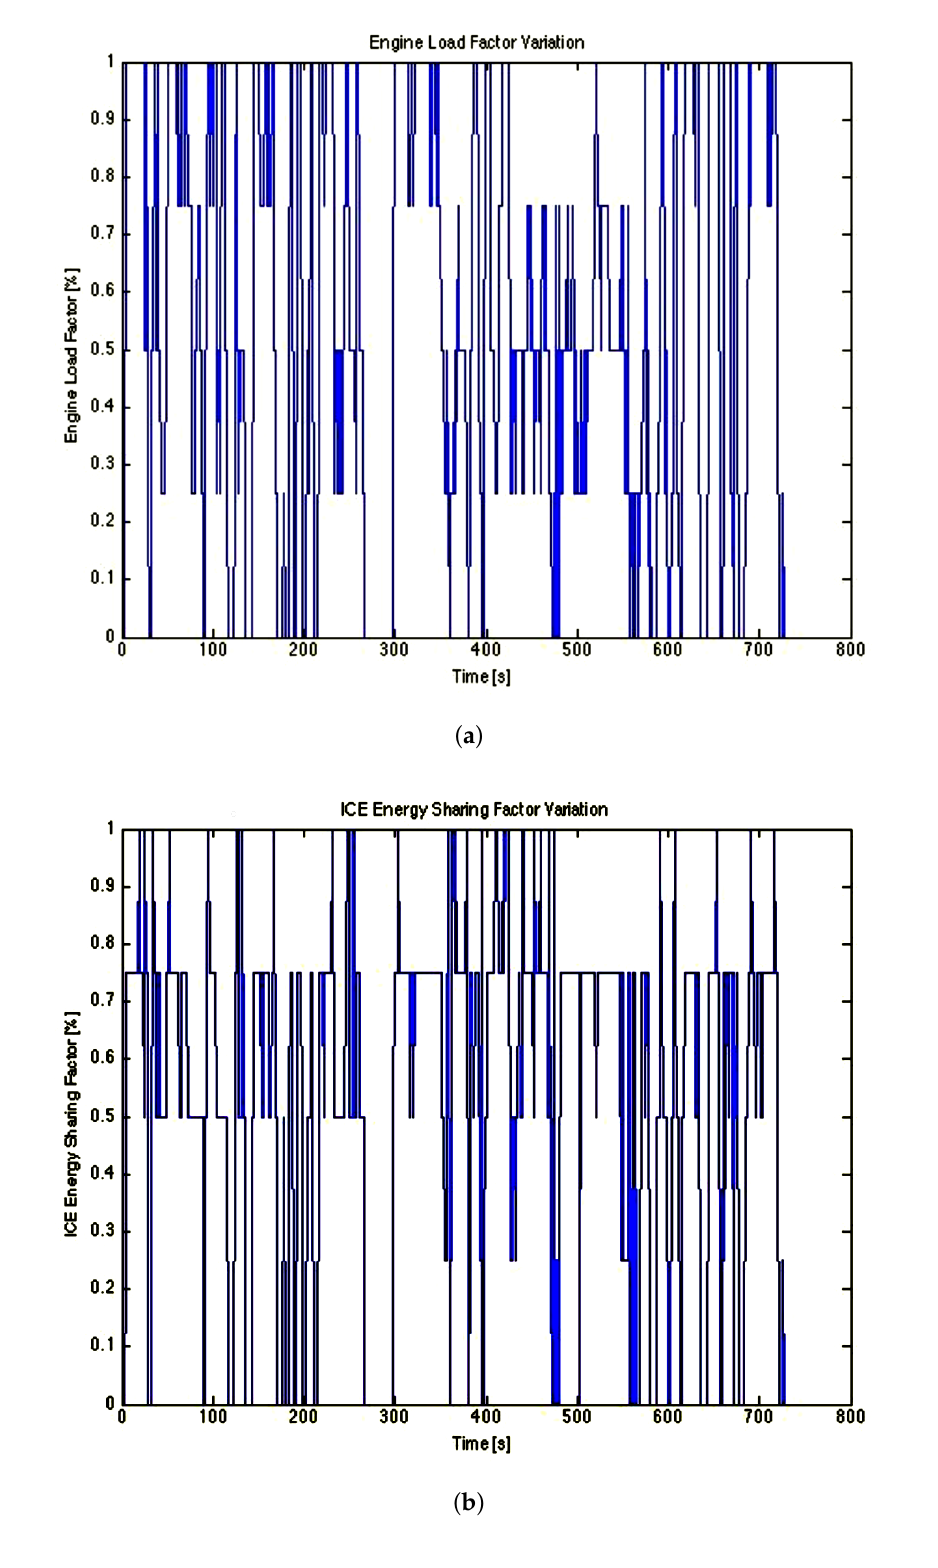
Figure 12. FHDS driving cycle with a 10% reduction of the thermal engine size w.r.t. Figure 11. ( a ) ICE load factor; ( b ) ICE energy sharing